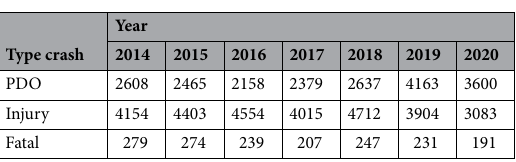
Table 2. The annual number of crashes for each severity